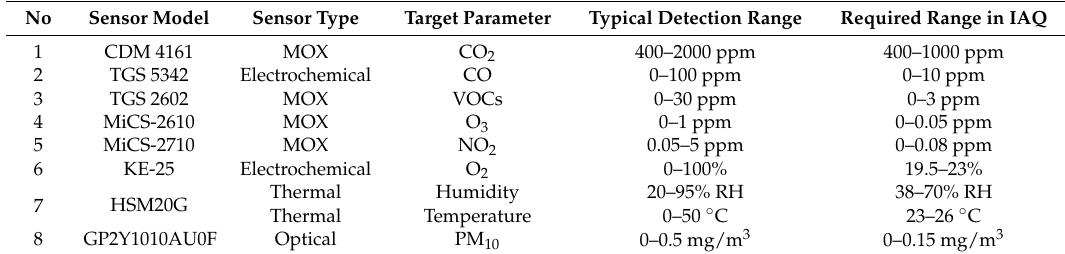
Table 1. List of sensors used in the system.